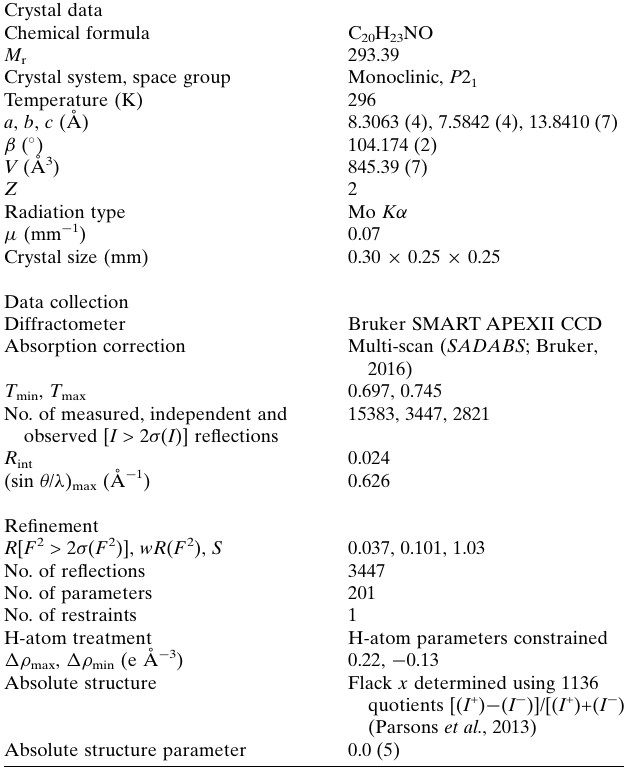
allowed to ride on their parent atoms, with U 1.5U (C) for methyl H and 1.2 U eq